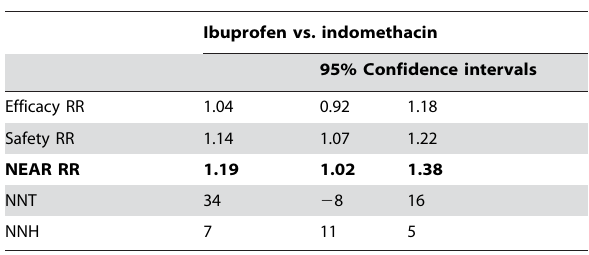
Table 7. Results of classical RR, NNT and NNH variables together with NEAR RR for a CRT comparing ibuprofen vs. indomethacin for the closure of patent ductus arteriosus [7].